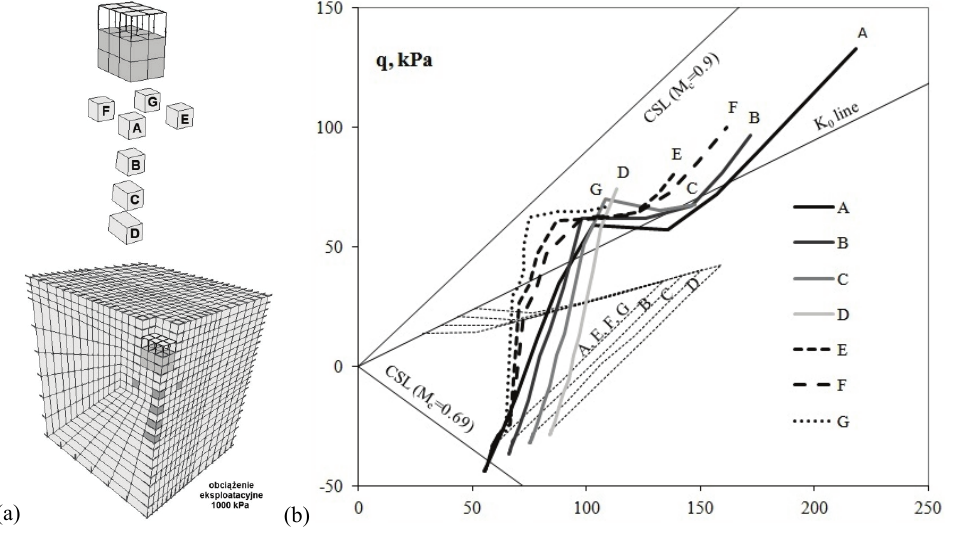
Fig. 1. (a) FEM model of the footing with elements chosen for the analysis; (b) stress paths at elements